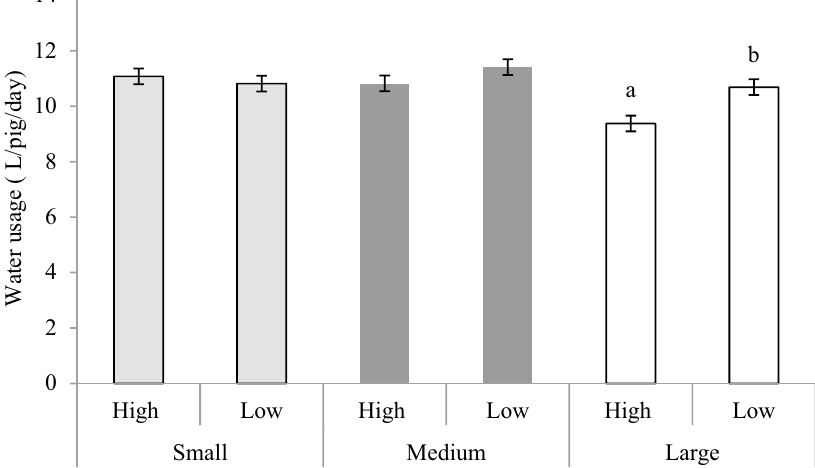
Figure 1. Effect of group size and enrichment on the water usage (ingested + wasted) L/pig/day (LSmeans ± SE). Group size: Large (48 pigs/pen), Medium (24 pigs/pen), Small (12 pigs/pen), Enrichment: Low (Wood + Hanging toy), High (Wood + Hanging toy + Grass). abc Different letters denote significant differences picked up by Tukey–Kramer test ( p < 0.05).